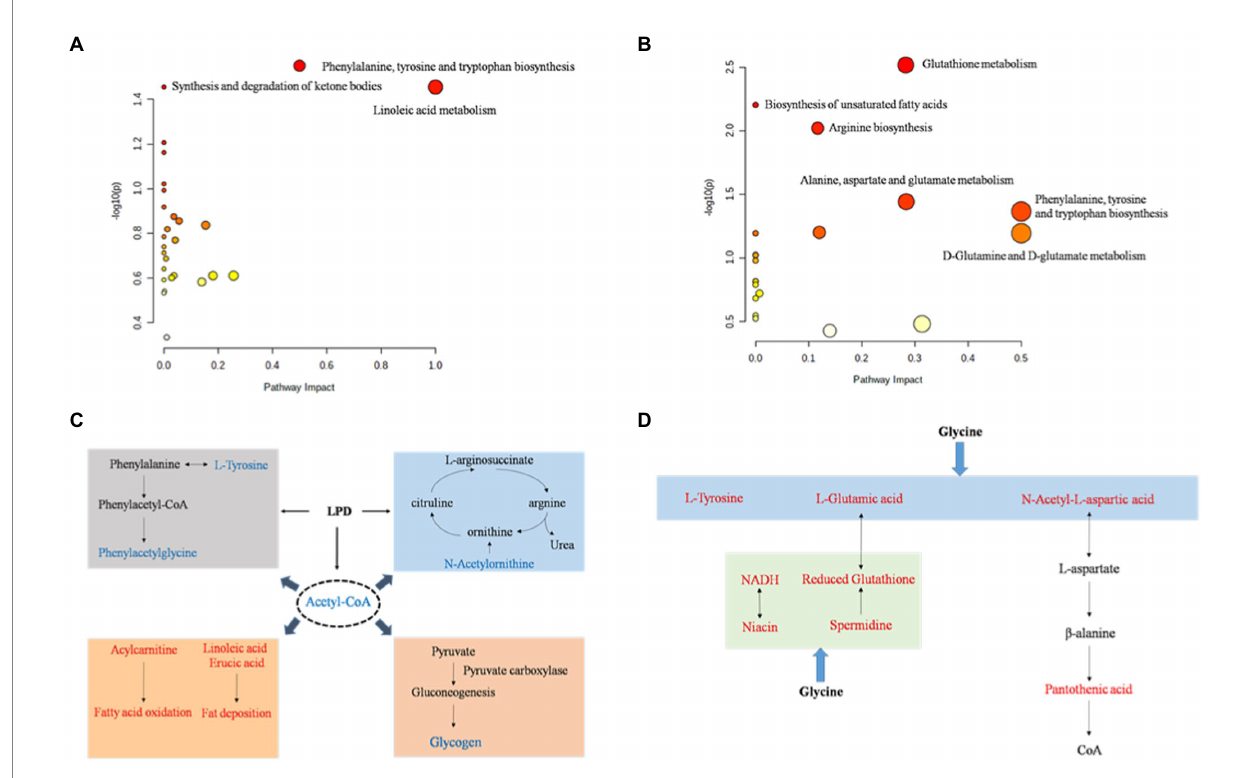
FIGURE 3 The perturbed metabolic pathways (A , B) and networks (C , D) associated with low protein diet (A , C) and glycine supplementation to low protein diet (B , D) . Metabolites in red were up-regulated and metabolites in blue were down-regulated. p < 0.05, n =